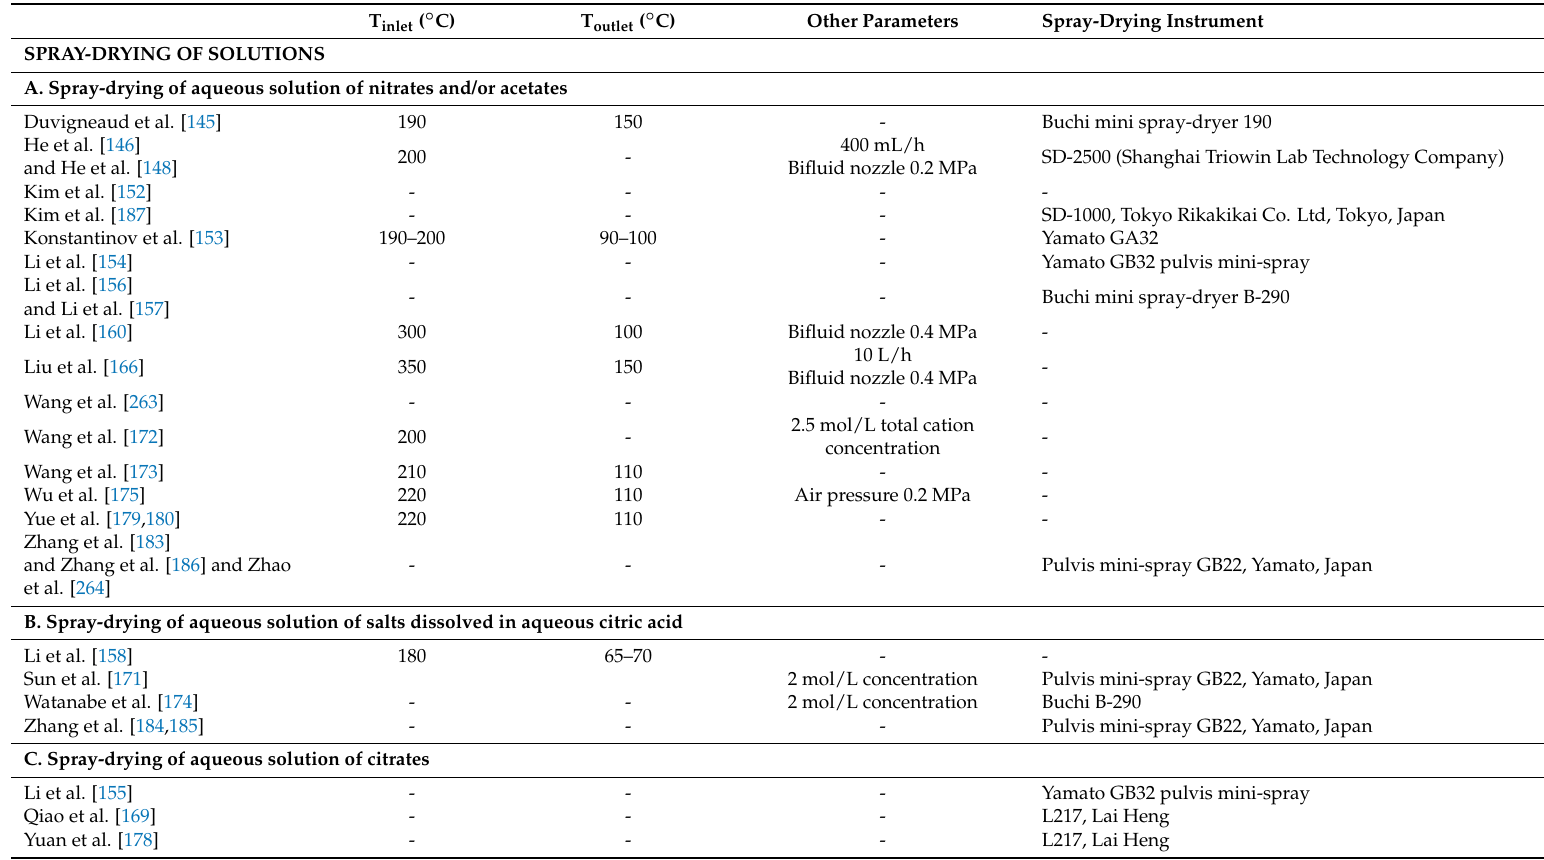
Table A1. Spray-drying parameters for layered oxides AMO 2 (A = Li + , Na + ; M = Li, Ni, Mn, Co, Al, . . . ) Sections in the table are the same as in Table 3 (see main text) where compound stoichiometries and solution/suspension compositions can be found. Information about the spray-drying instruments is given as provided in the referenced papers. - = not